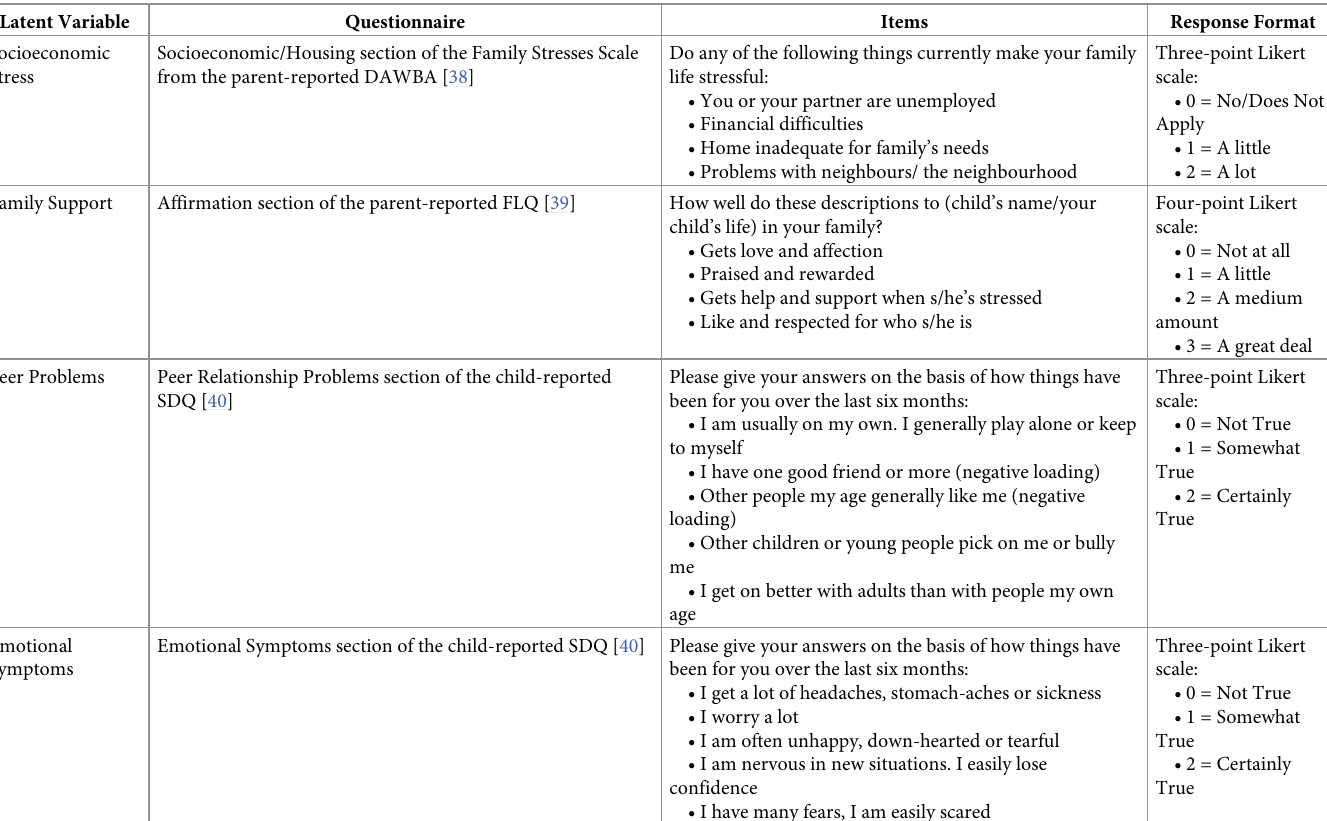
Table 1. Information on the items used to construct latent variables for socioeconomic stress, family support, peer problems and emotional symptoms. Latent